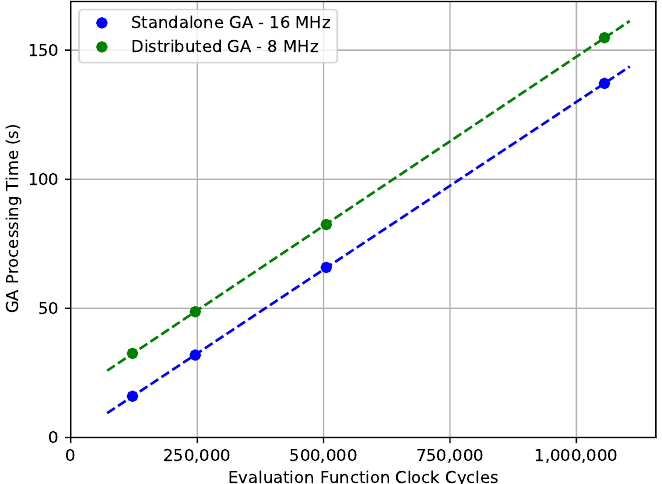
Figure 25. Comparison of standalone GA (1 node) and distributed GA (2 nodes) processing time with different clock